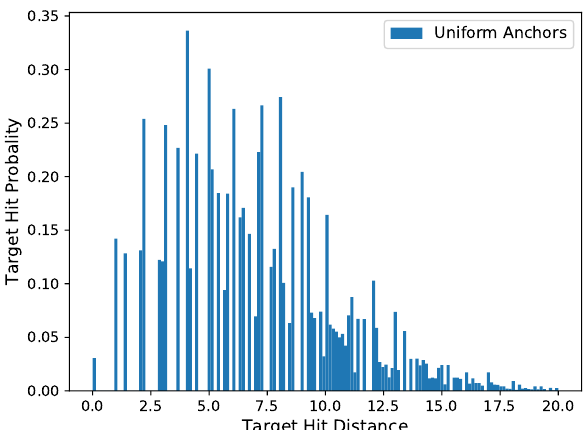
Figure 2. The hit distance histogram calculated in COCO2014 mini-validate set. All anchor locations are uniformly sampled on the original images with a sampling stride of 14 pixels. The size of the original image is 1024 × 1024 × 3. We expect the histogram distribution can be as closer to Y -axis as